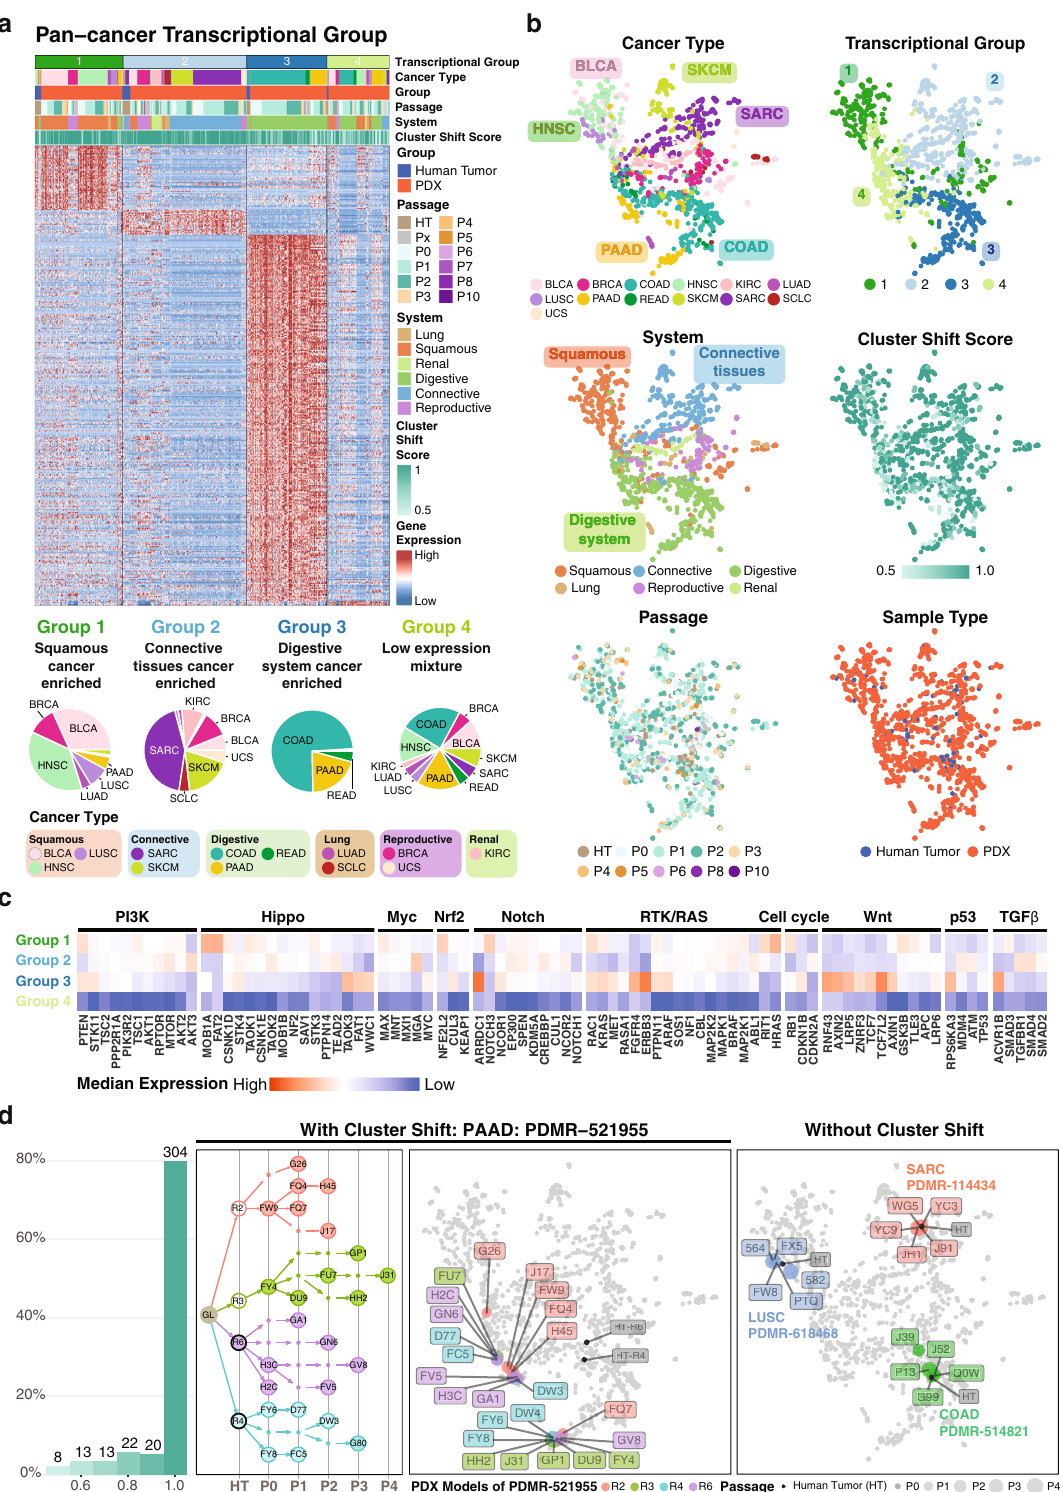
( p = 2.05 × 10 – 7 , chi-square test) between subclonal CNAs and LOH events in TP53 , supporting the view that TP53 mutations lead to higher genomic instability. Using HATCHet, we also searched for samples with CNAs that are not present in other samples from the same case (inter-sample subclonality), fi nding 75 instances. Subclonal CNAs and different CNAs across samples from the same case suggest ongoing clonal dynamics between multiple samples